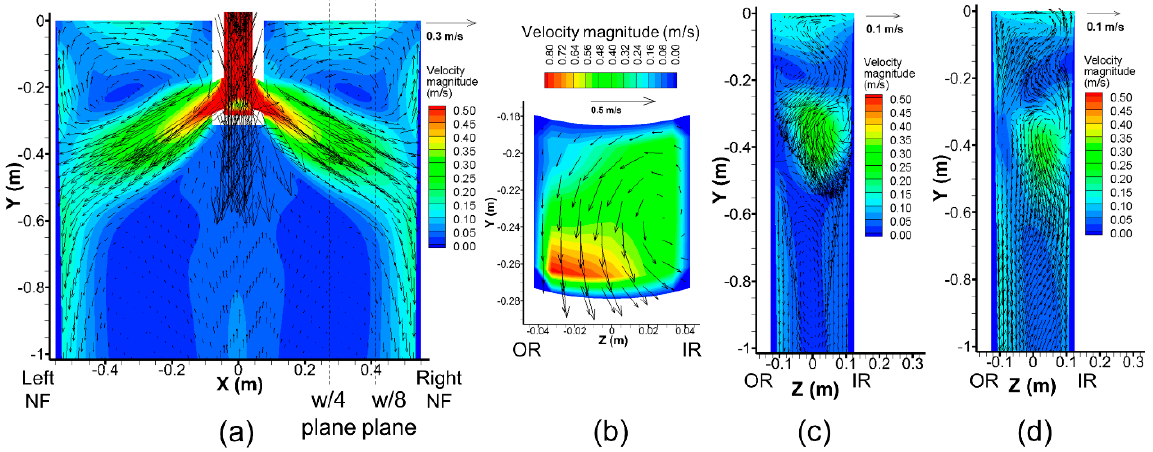
Figure 6. Jet behavior at ( a ) the center middle-plane (front view between IR and OR), ( b ) the nozzle port, ( c ) the w/4 plane (side view midway between SEN and NF), and ( d ) the w/8 plane (side view near NF) in the mold.